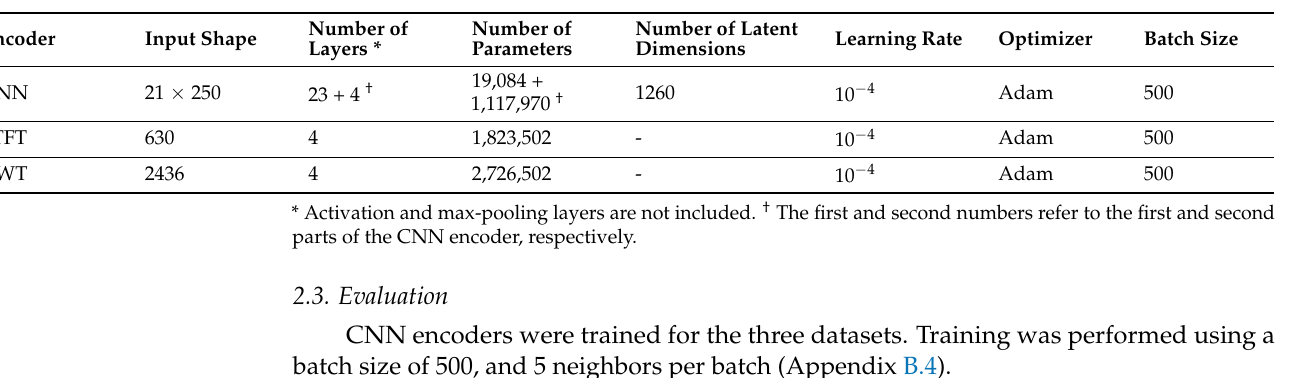
Table 1. Summary of the main configurations of the encoders of the